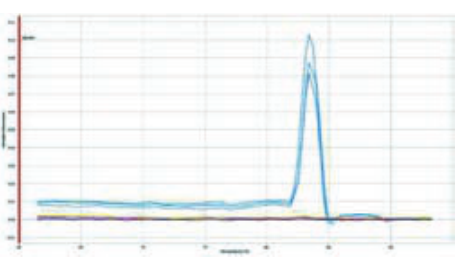
Fig. 7 Melt curve of real time PcR assay for ISCfe-1 gene from positive control and clinical